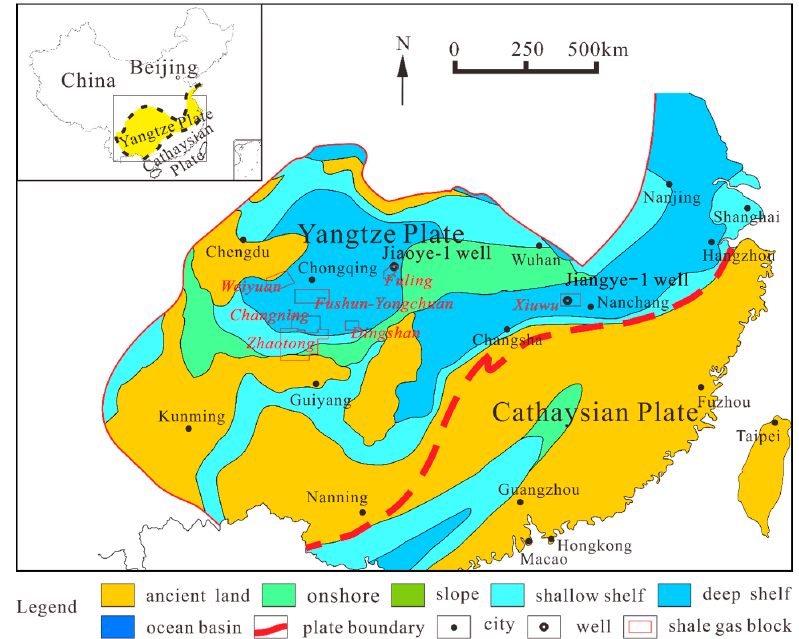
Figure 1. Sedimentary characteristics of the Late Ordovician–Early Silurian in southern